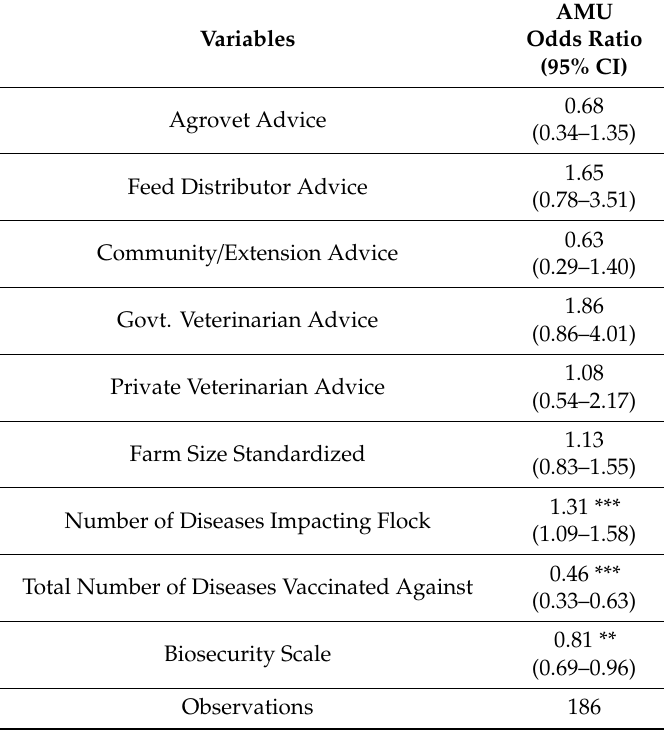
Table 7. Monthly antimicrobial usage during the production cycle. An ordinal logistic model with an outcome variable of antimicrobial use (AMU) across a typical month as reported by respondents. AMU is categorized into 0 = never, 1 = 1 to 2 times, 3 = 3 to 5 times. 95% confidence intervals (CIs) are presented below odds ratio estimates. See Table 2 for variable